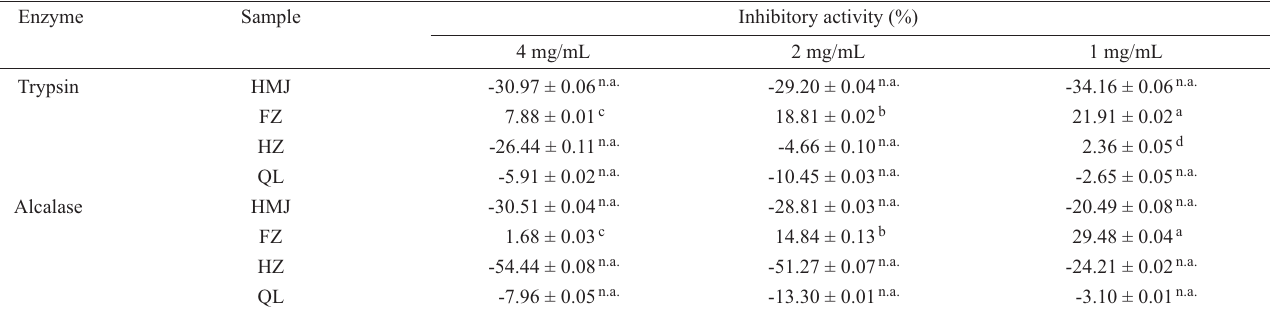
Tab. 1: Inhibitory activity (%) of four kinds of dark tea hydrolysates generated by trypsin(a) and Alcalase(b) against α-amylase at concentrations of 1 mg/mL, 2 mg/mL, and 4 mg/mL. Concentrations of 4–8 mg/mL were also investigated in the study but not included in this paper. Mean ± SD (n=3). n.a. = no inhibition detected. Values with different letters are significantly different at p < 0.05.